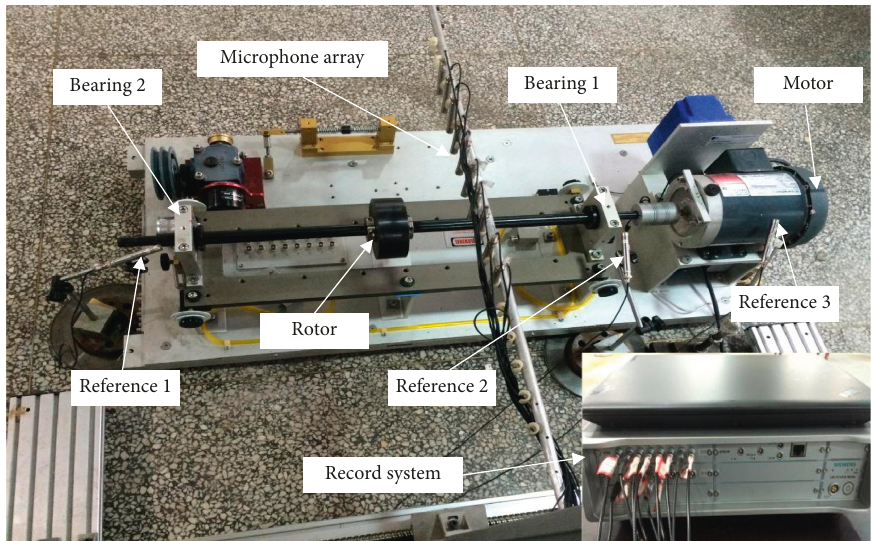
Figure 4: Bearing test rig.